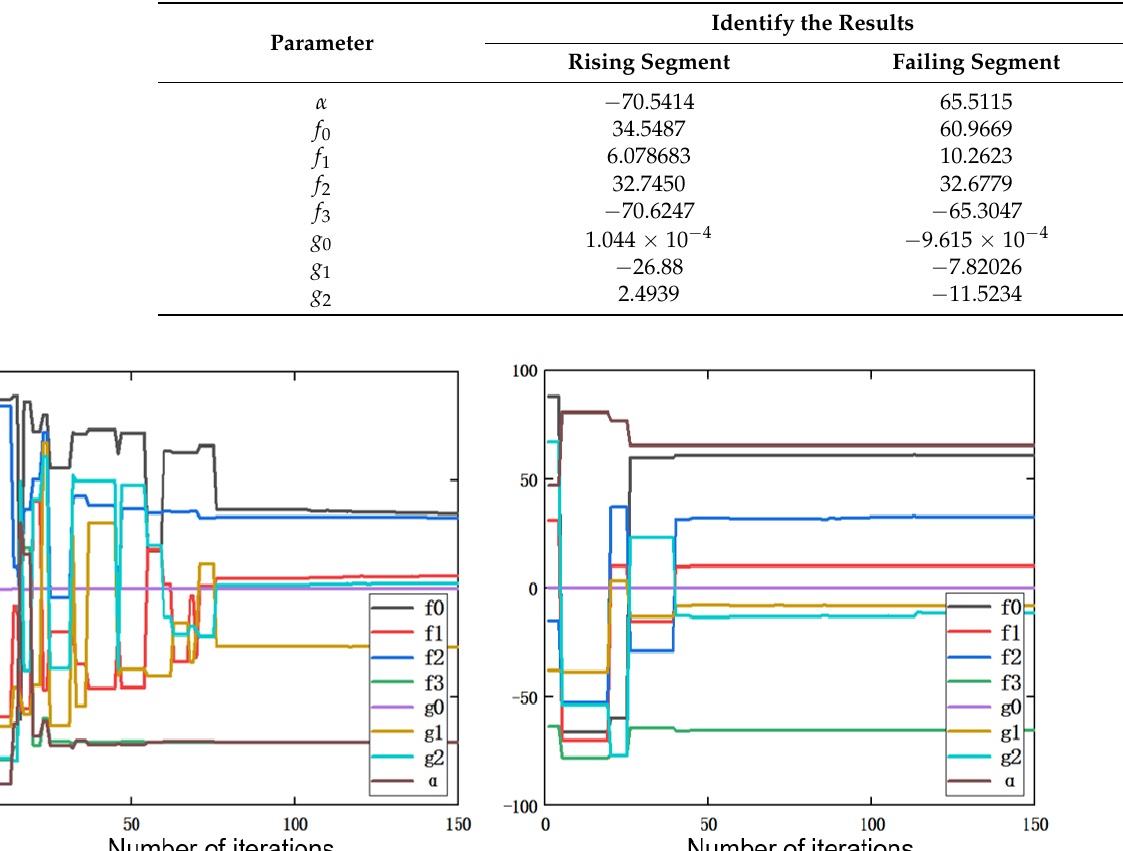
Table 2. Improved artificial fish swarm algorithm segmentation identification model parameters.